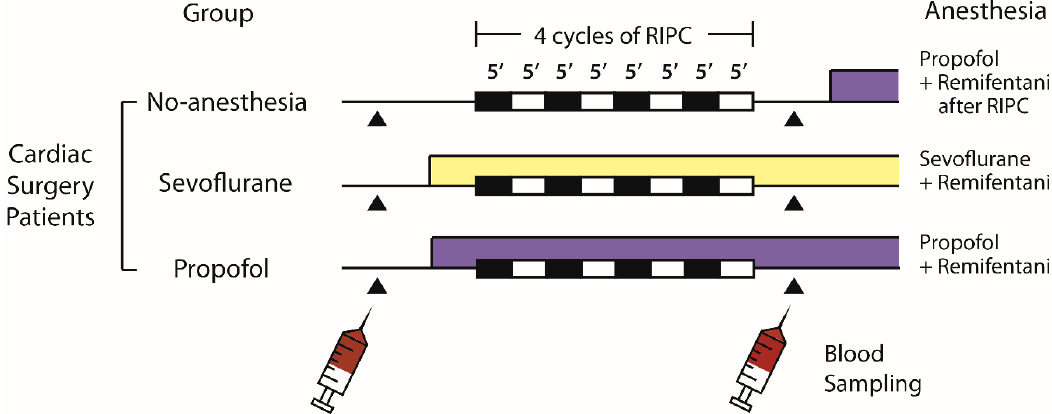
Figure 5. Schematic diagram of the study protocol of cardiac surgery patients. RIPC, remote ischemic preconditioning.